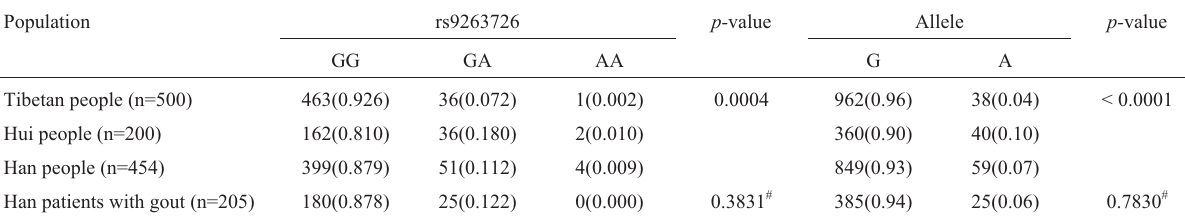
Table 1 - Allele and genotype frequencies of rs9263726 in Han, Tibetan, and Hui people. Population